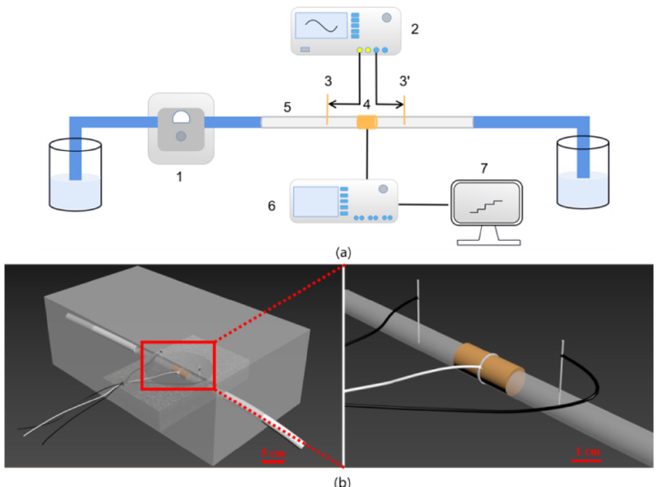
Figure 1. The measurement principle of DISODCD. ( a ) A plan of the experimental setup: (1) Peristaltic pump; (2) Function generator; (3) Input electrodes; (4) Output electrode; (5) Plastic pipe; (6) Lock-in amplifier; (7) Signal collector. ( b ) The model figure of the sensing section.